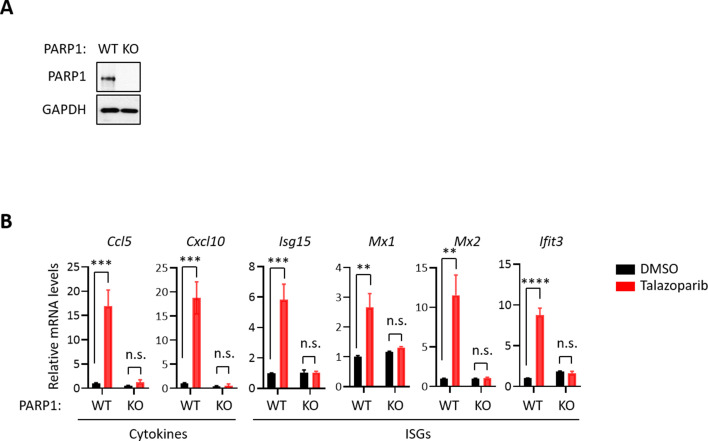
The PARP1 protein is required for PARPi-induced innate immune response.(A) The level of PARP1 in WT and PARP1 KO HeLa cells. Whole cell lysates were probed using the indicated antibodies. GAPDH used as the loading control. (B) RT-qPCR analyses of cGAS-STING target gene expression in WT and PARP1 KO HeLa cells that were treated with or without Talazoparib (10 µM for 72 hr). Values of cytokines and ISGs mRNA levels were presented as means ± SEM from three biological replicates. Significance was determined with two-way ANOVA. **p < 0.01, ***p < 0.001, ****p < 0.001, n.s., not significant.